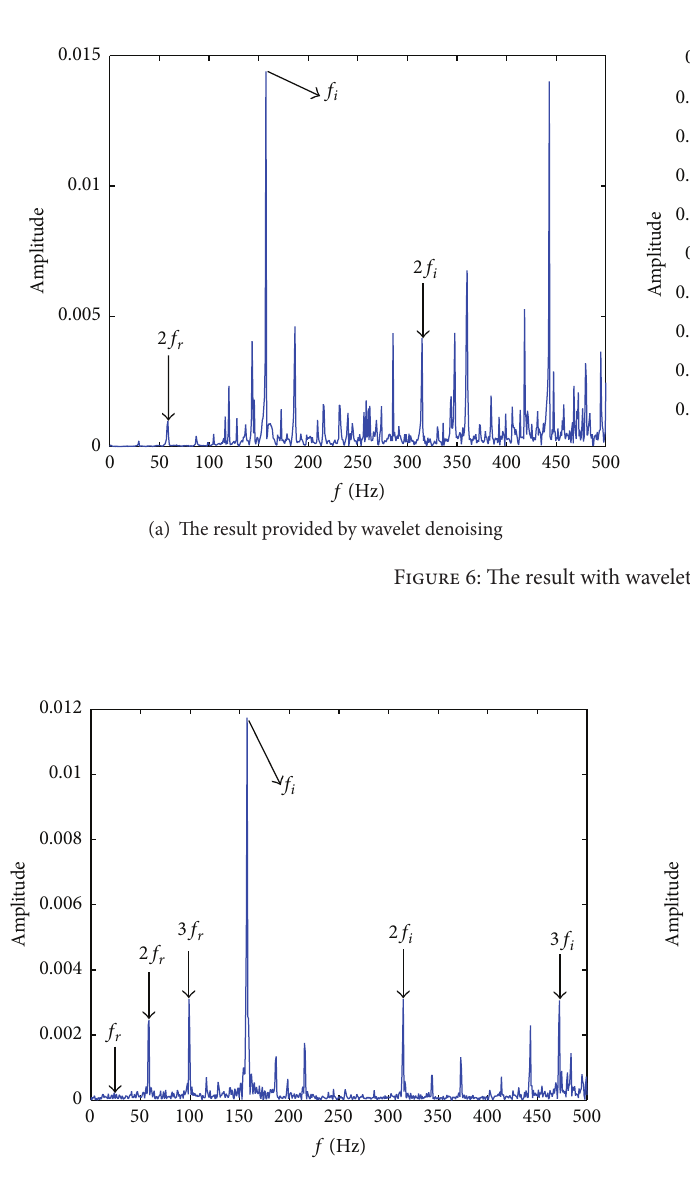
Figure 7: The result obtained from the proposed method (IWATV).